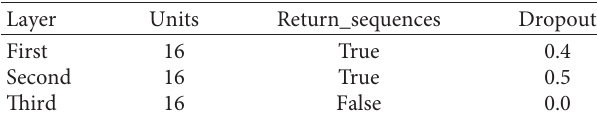
Table 2: GRU network parameters